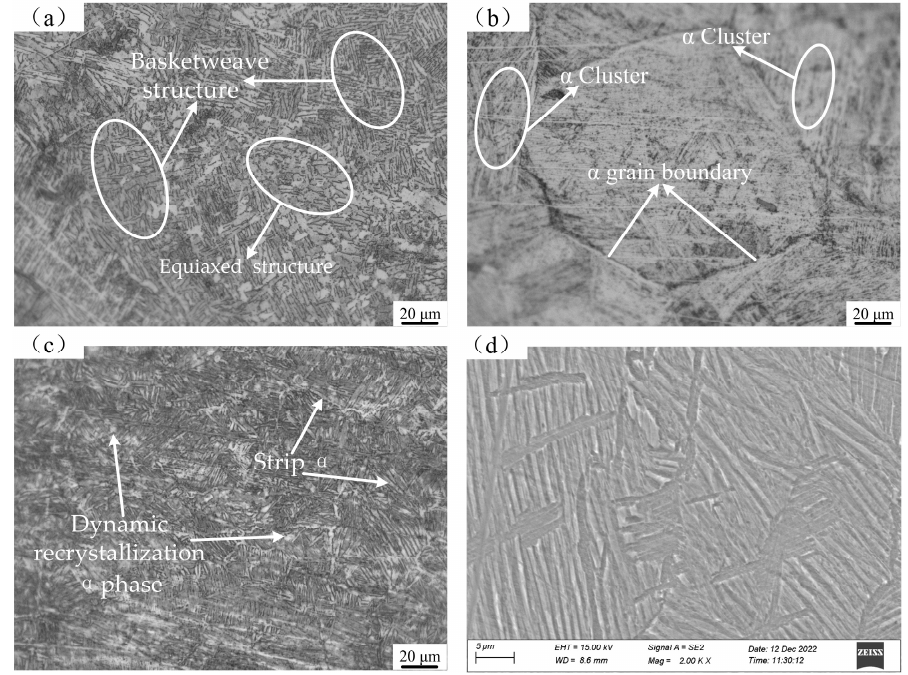
Figure 12. Metallographic microstructure: ( a ) TC4ELI bar, ( b ) tube after piercing and ( c , d ) tube after the TSR process.